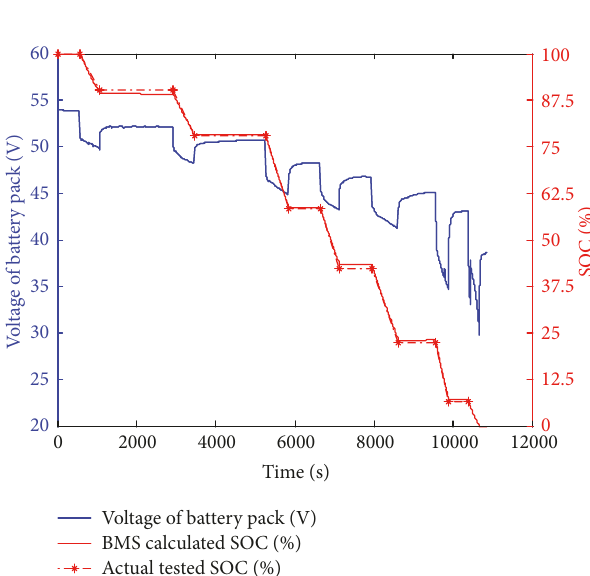
Figure 10: Effect of equalization.